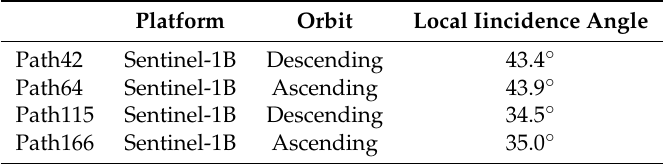
Figure 4. Mean monthly temperature (Orange line) and precipitation (Blue bar) around the study area. These climate statistics were recorded at a weather station in the Omak airport in 2018 and provided by the National Center for Environmental Information (https://www.ncdc.noaa.gov/). Table 1. Properties of each acquisition path that can capture our study